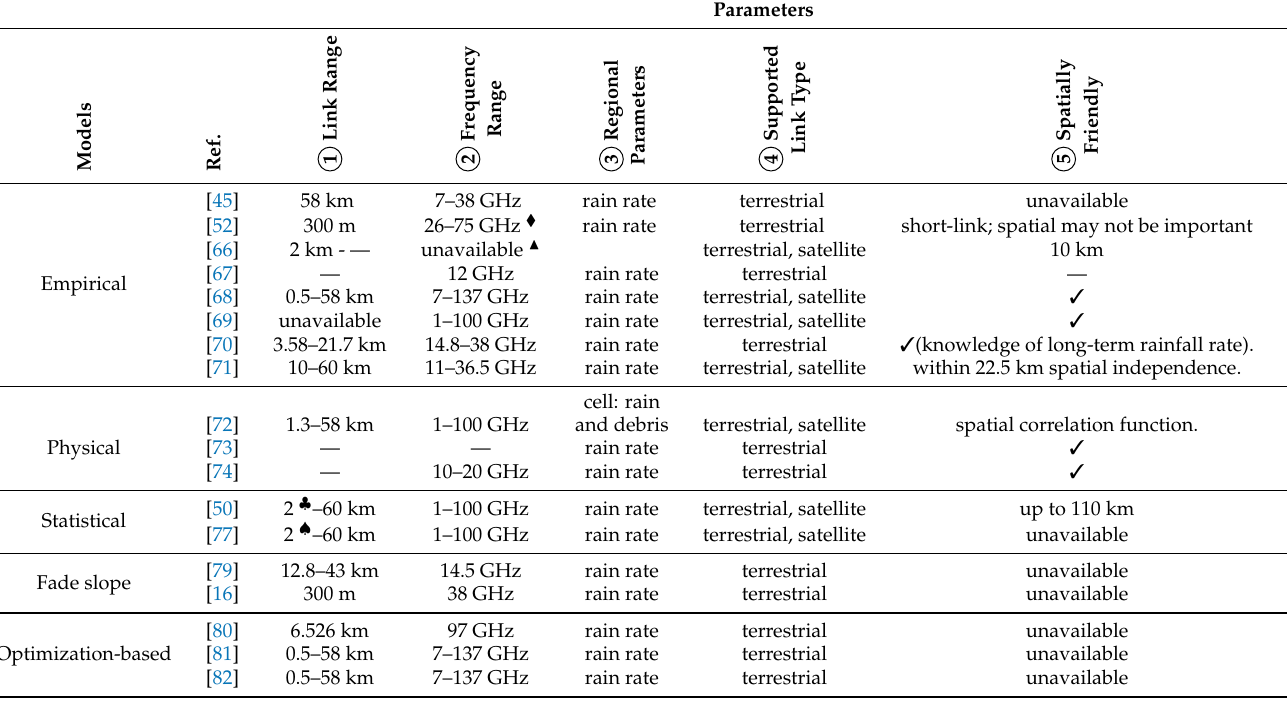
Table 6. Properties of rain attenuation